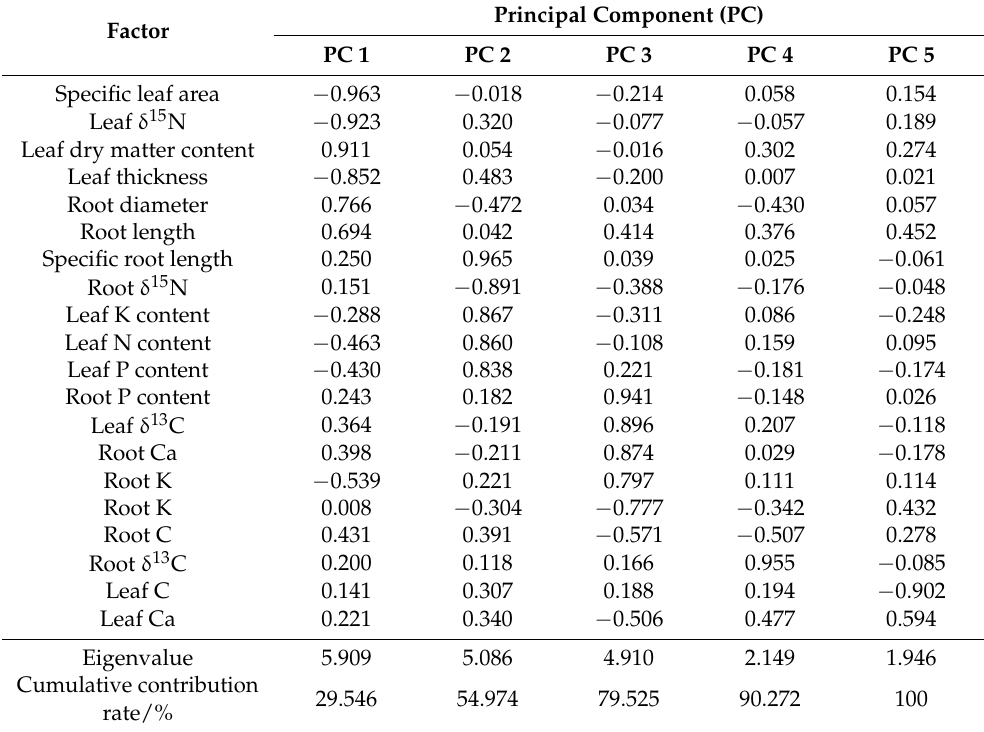
Table 3. Principal component analysis of plant functional